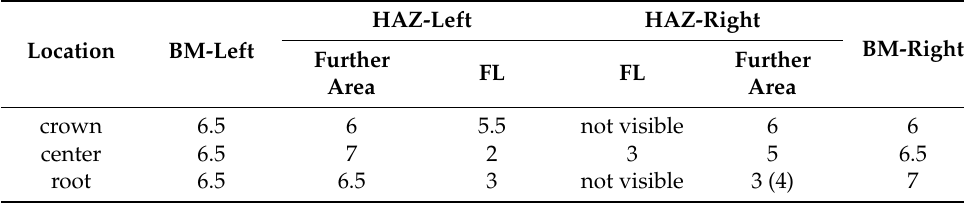
Table 4. Grain size G in the N sample, aged at 650 °C for 7,560 h.